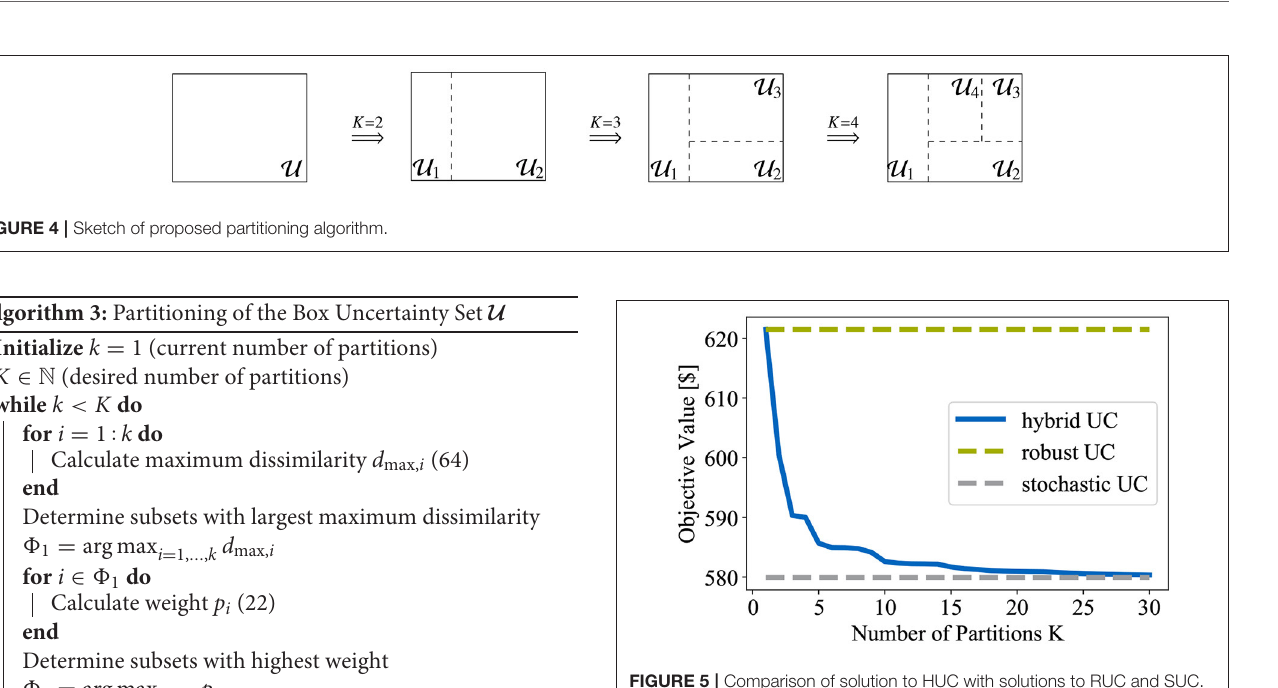
various K . The partitions are obtained by running Algorithm